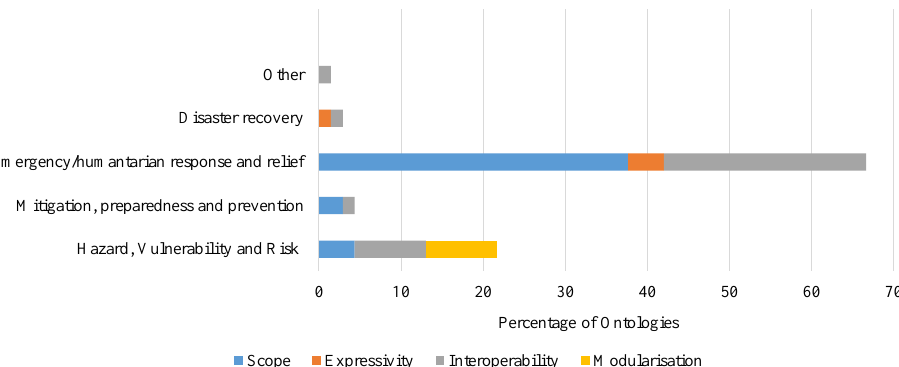
Figure 3. Motivation for Developing Ontologies within the Disaster Sub-domains.